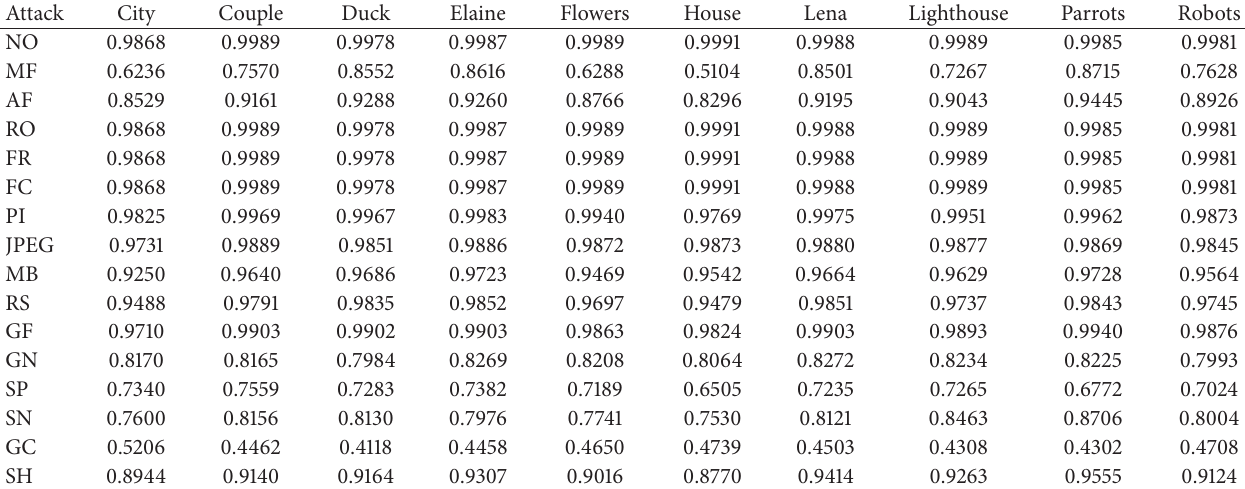
Table 2: Correlation values of the extracted watermarks by the proposed scheme corresponding to WM1.